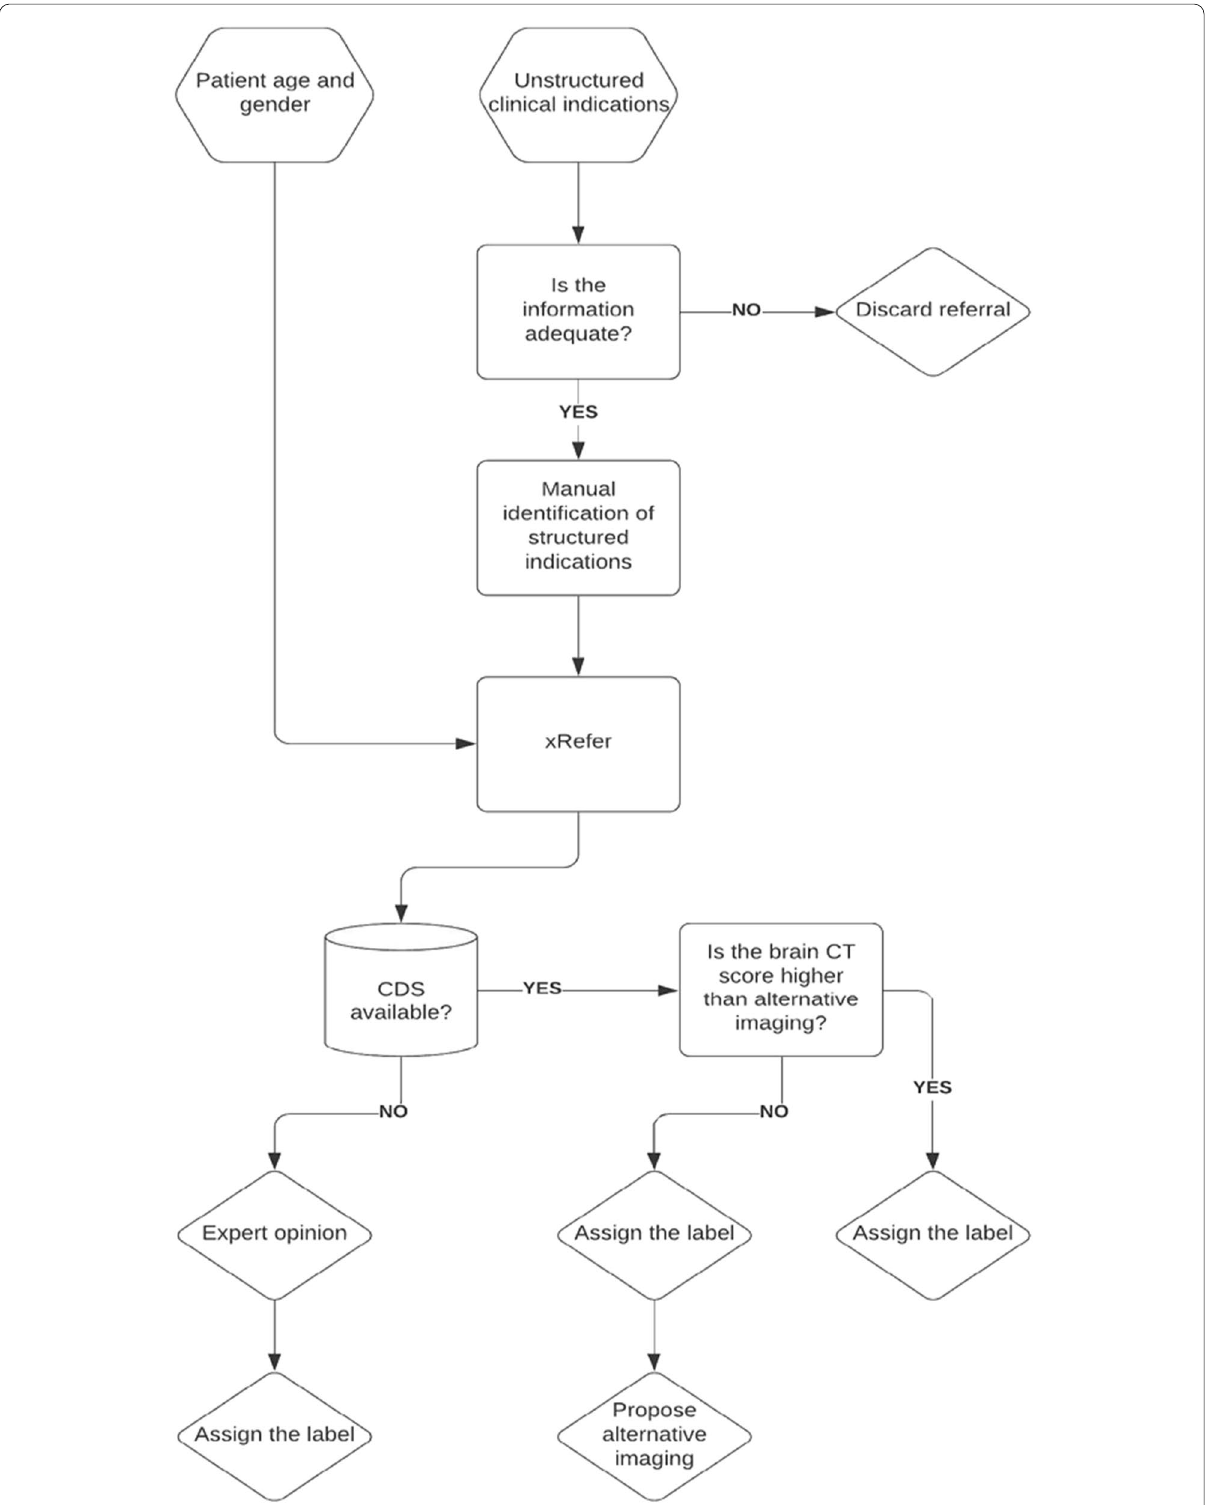
Fig. 1 Semi-automated vetting pipeline for brain CT